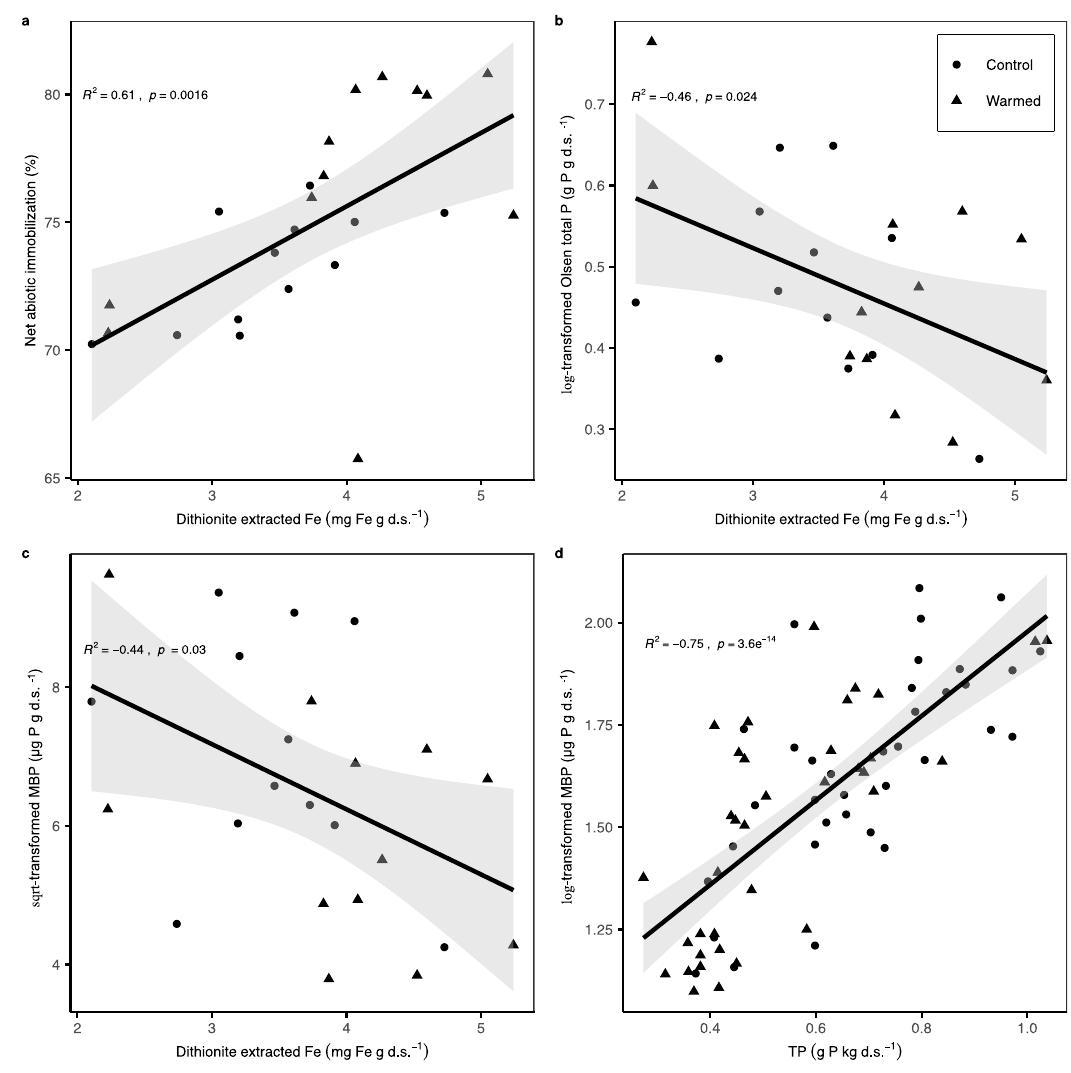
Fig. 3 | Pearson correlations. Correlations between a netabiotic P immobilization and dithionite extracted Fe( n =24), b log-transformed OlsentotalP and dithionite extracted Fe( n =24), c sqrt-transformedmicrobial biomass P (MBP)and dithionite